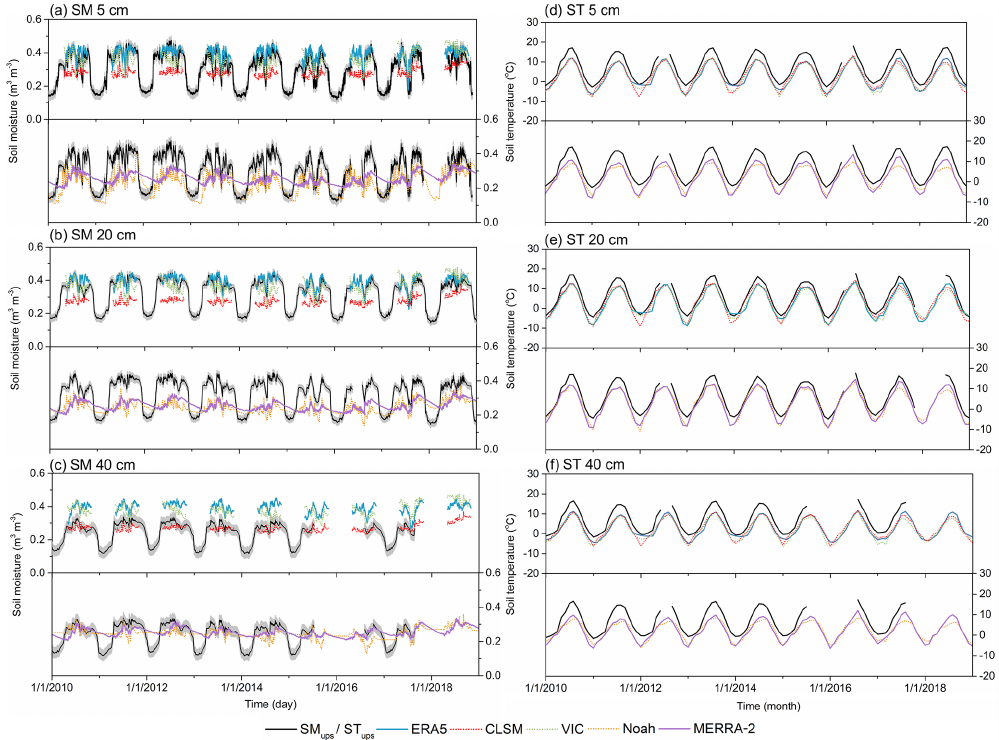
Figure 11. Time series of daily average SM (a–c) and monthly mean ST (d–f) at soil depths of 5 (a, d) , 20 (b, e) , and 40cm (c, f) , as derived from the upscaled SMST dataset and five model-based products from January 2010 to December 2018 for the Maqu